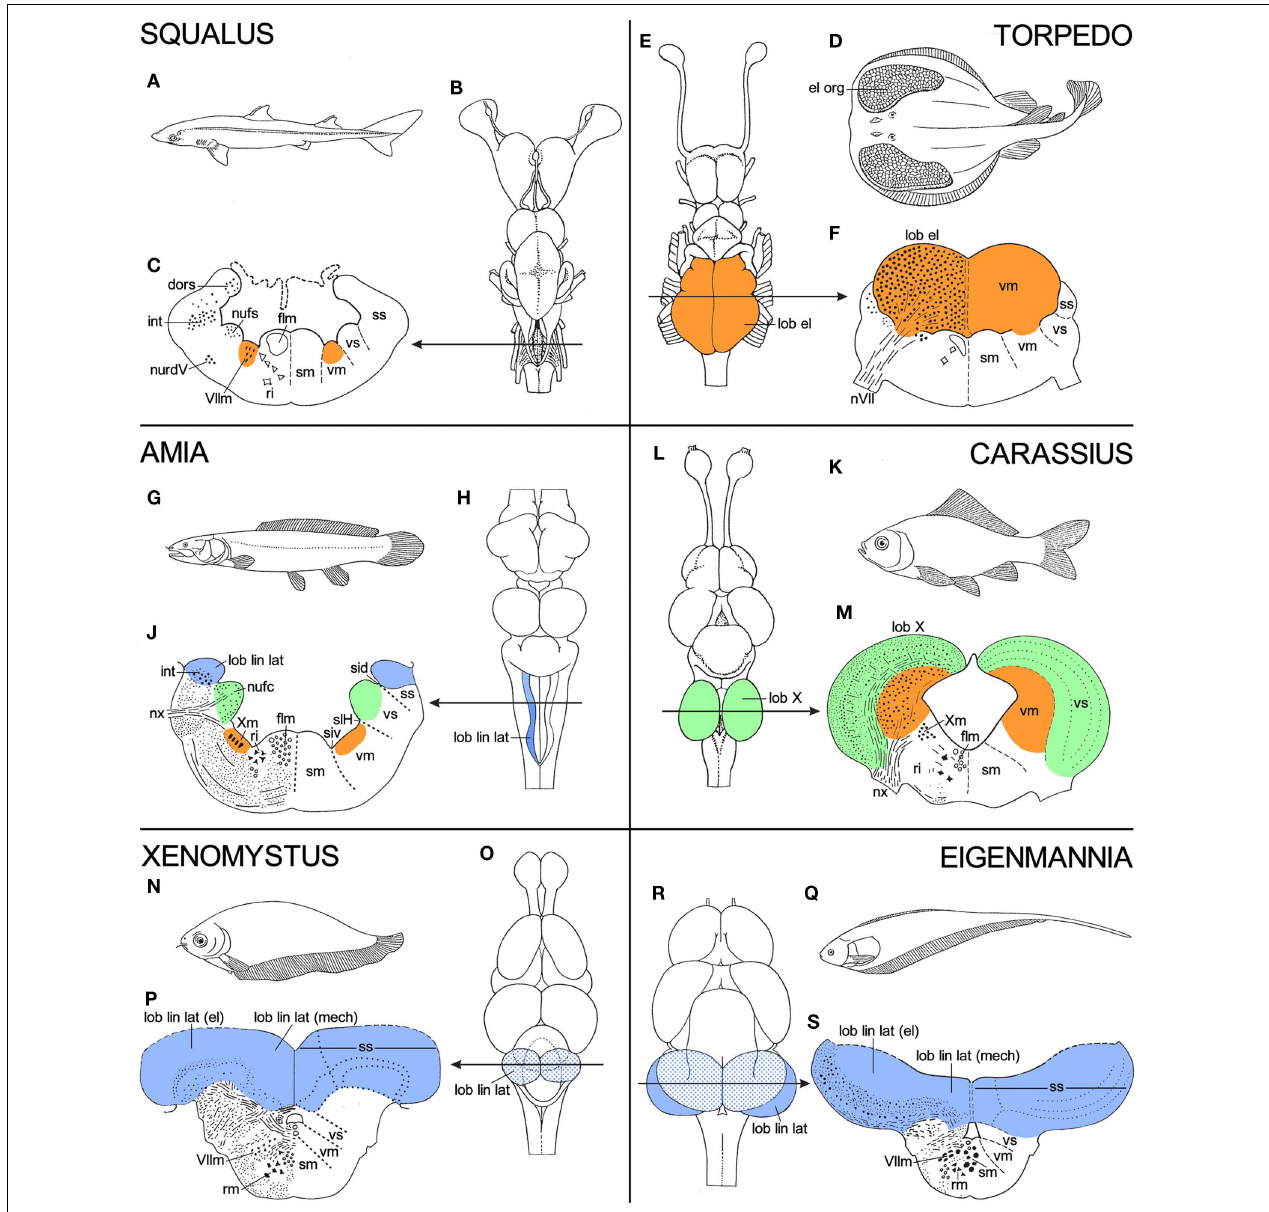
Torpedo , Carassius , Xenomystus , and Eigenmannia show functional specializations, which manifest themselves as local “hypertrophies” in their brains. In order to place these specializations into perspective, the brains of these four species are compared to those of two “less specialized” or “more generalized” fishes, viz. Squalus and Amia . For further explanation, see